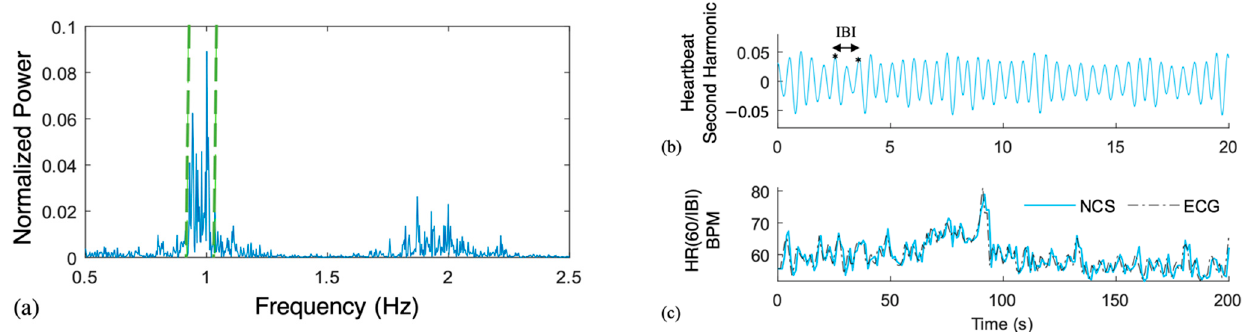
Figure 3. ( a ) Frequency spectrum of NCS thorax waveforms during the relaxation routine of 5 min showing variable HR in the range [0.93,1.04] Hz, indicated by the dashed green lines. Similarly, the second harmonic of heartbeat is also distributed around 2 Hz. ( b ) Second harmonic NCS heartbeat waveform, where IBI is taken as the time for two cycles. ( c ) Instantaneous HR (60/IBI) in BPM from NCS and ECG showing high correlation. The HR shows strong variation from 50–80 BPM in a resting